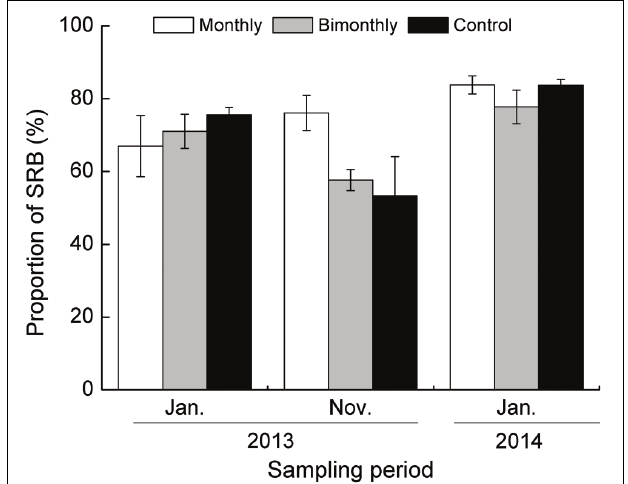
FIGURE 4 | Proportion of short rhizome buds (SRB) to total rhizome buds (TRB) of C. brevicuspis populations for three defoliation frequencies in January and November 2013 and January 2014. The data are expressed as the mean ± standard error (SE). ∗ p < 0.05.